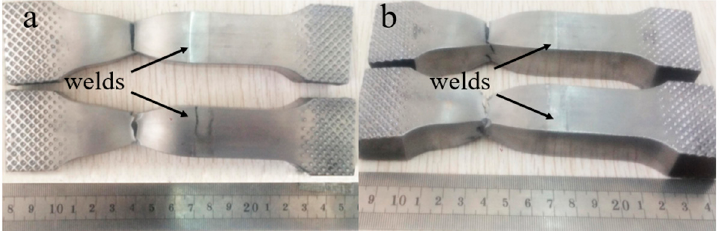
Figure 14. Tensile samples. ( a ) Tensile samples for one time welding. ( b ) Tensile samples for pre-heating, welding and post-heating.